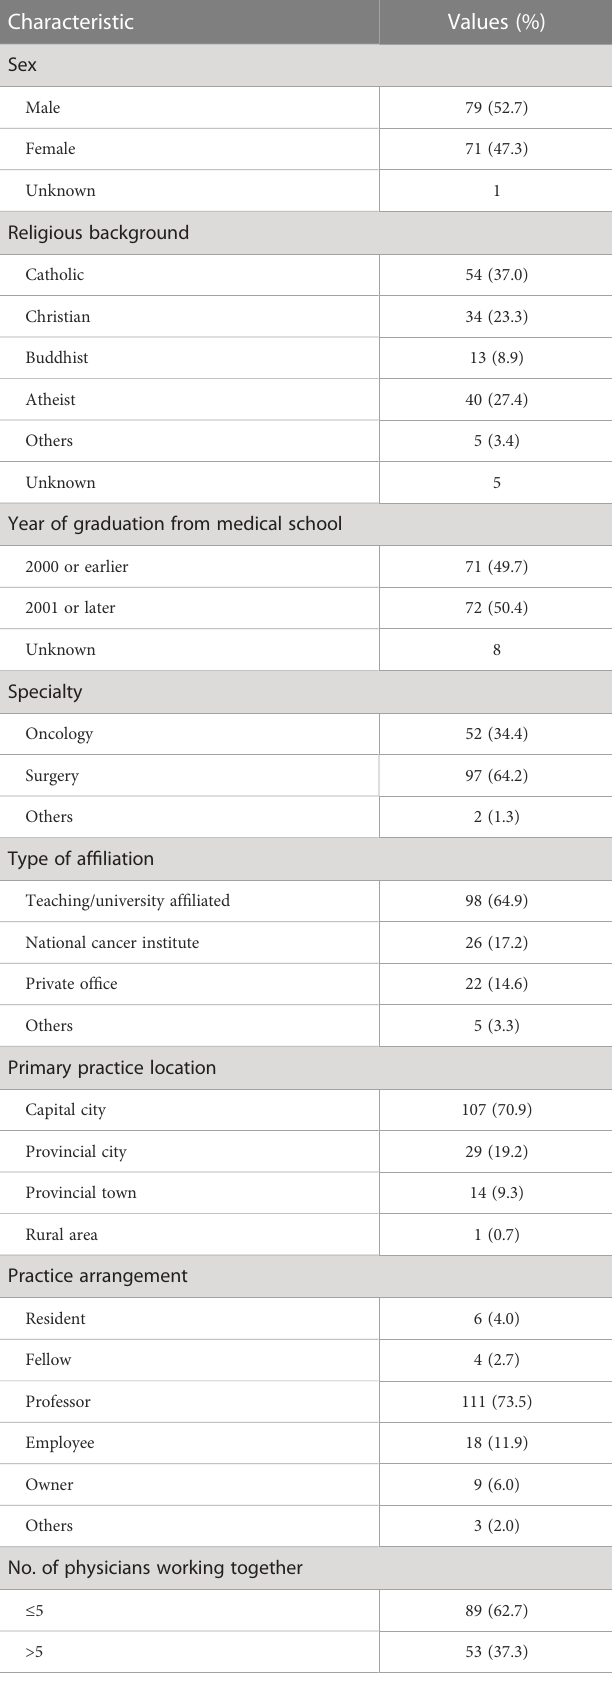
TABLE 1 Participants ’ characteristics (N =